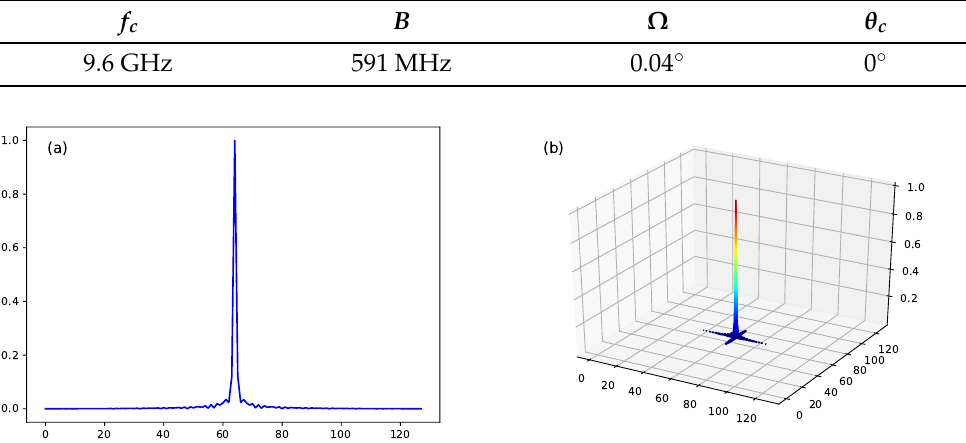
Figure 8. Filter used by CLEAN algorithm with SAMPLE dataset. ( a ) 2D plot; ( b ) 3D